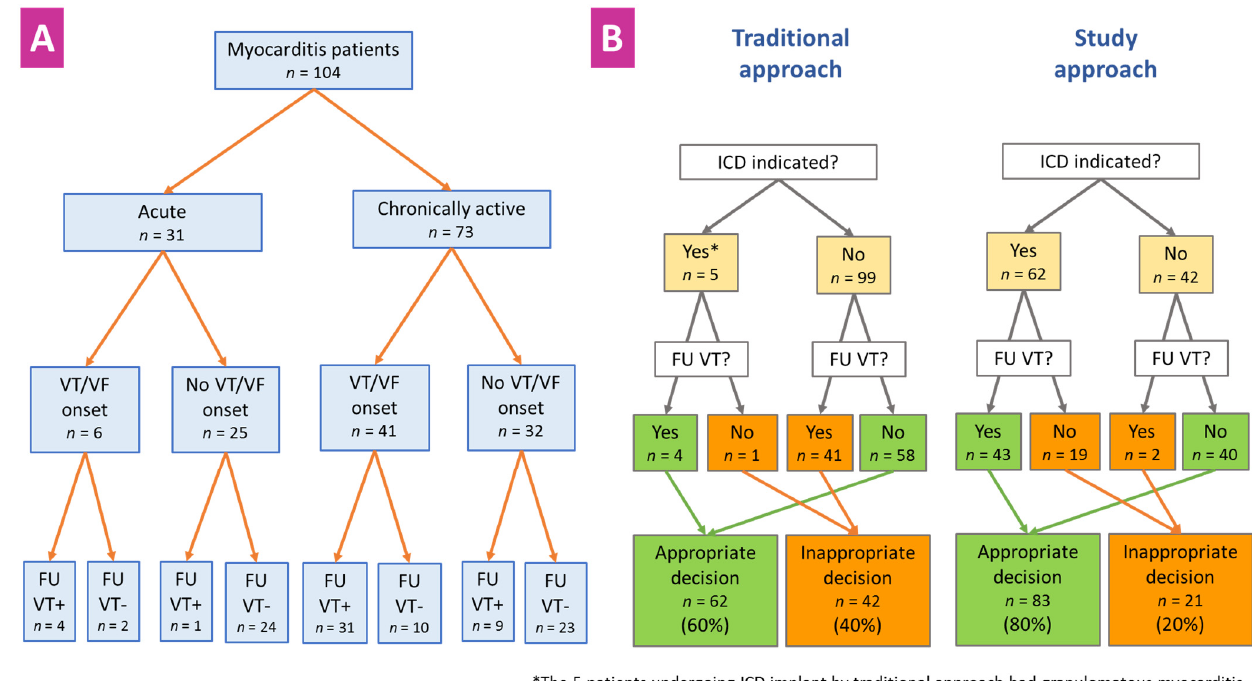
Figure 3. Events by myocarditis stage and implantation strategy. Panel A : VT events (VT+) in patients with true acute vs. chronically active myocarditis according to endomyocardial biopsy findings; Panel B : Appropriateness of the ICD implantation strategy by application of current guidelines for acute myocarditis (left panel) vs. by multiparametric approach as described in this study (right panel). FU = follow up; ICD = implantable cardioverter defibrillator; VF = ventricular fibrillation; VT = ventricular tachycardia.